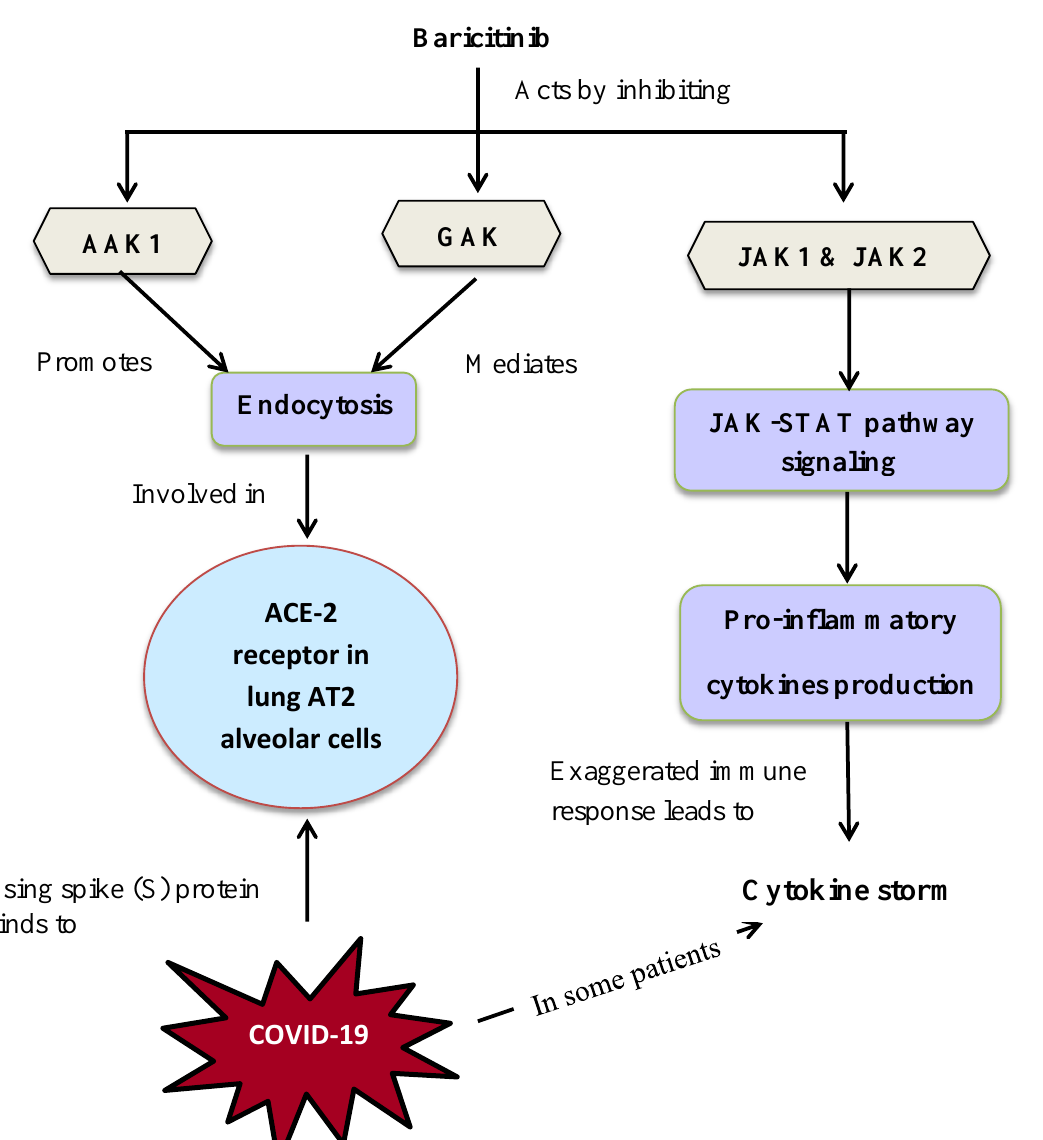
Figure 4.1: Explanation of possible modes of action of baricitinib in COVID-19. AAK1= AP-2 associated protein kinase-1; ACE2= angiotensin converting enzyme 2; GAK= cyclin G-associated kinase; JAK= Janus Kinase; STAT= signal transducer and activator of transcription proteins. Modified Richardson et al ., 2020 graph